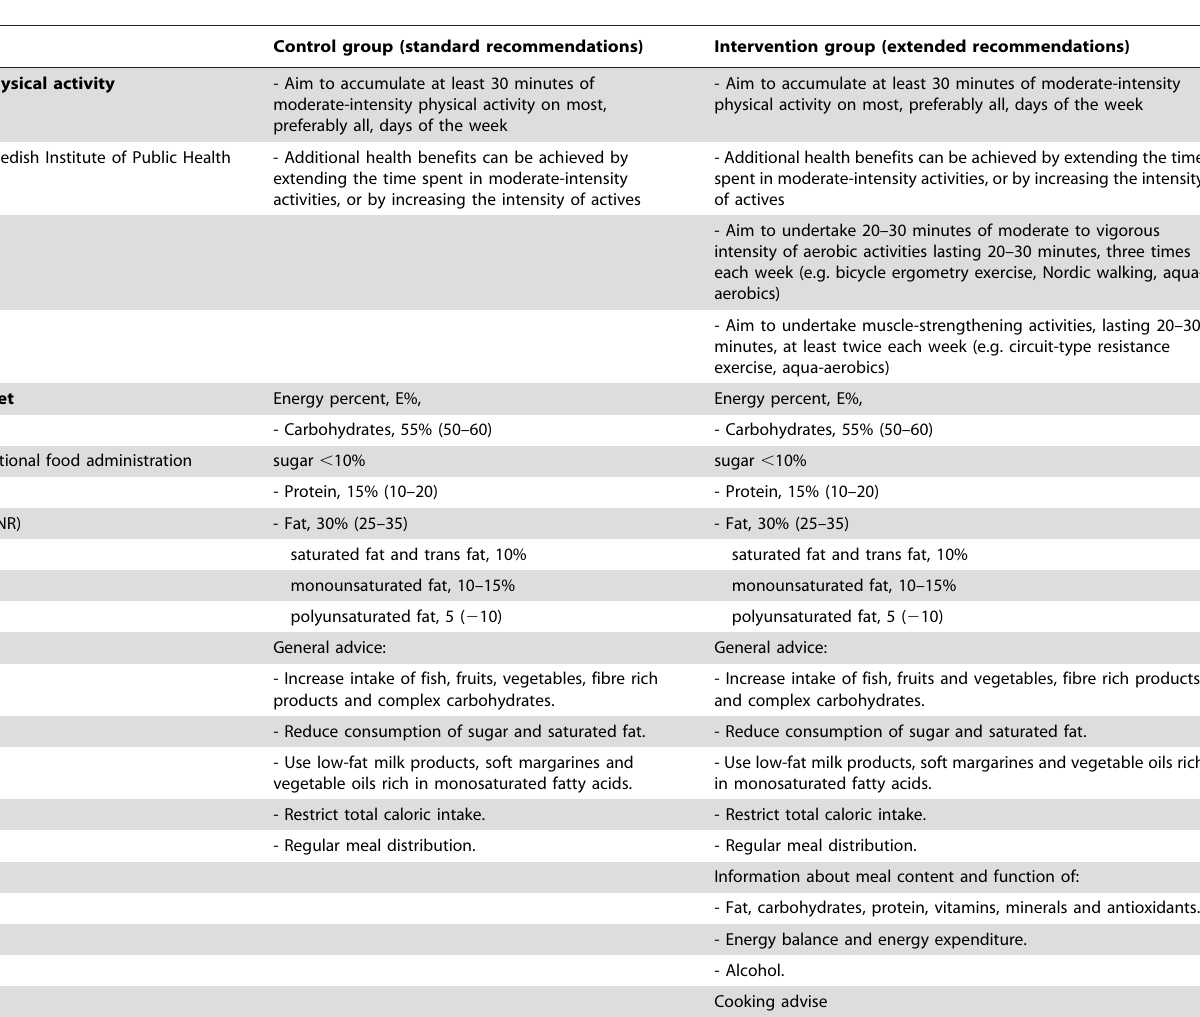
Table 1. Summary of physical activity and diet recommendations provided to participants randomized to the control and intervention